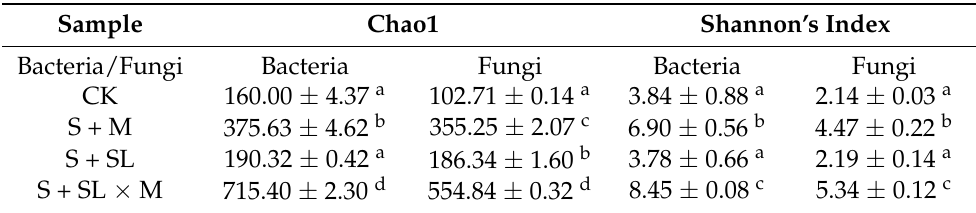
Figure 3. AGB (aboveground biomass) ( A ), CH (canopy height) ( B ), and MBC (microbial biomass C) ( C ) in the soil after harvesting at the same planting time for different treatments; different letters show significant differences between the mean values ( p < 0.05). CK refers to the untreated mining soil samples, S + M refers to the mining soil samples with the microbial agent, S + SL refers to the mining soil samples with water-jet loom sludge samples mixed at a ratio of 2.5:1, and S + SL × M refers to the mining soil samples with water-jet loom sludge samples and the microbial agent. Table 3. Shannon’s and Chao1 indices of the bacterial and fungal community under the 97% similarity level.